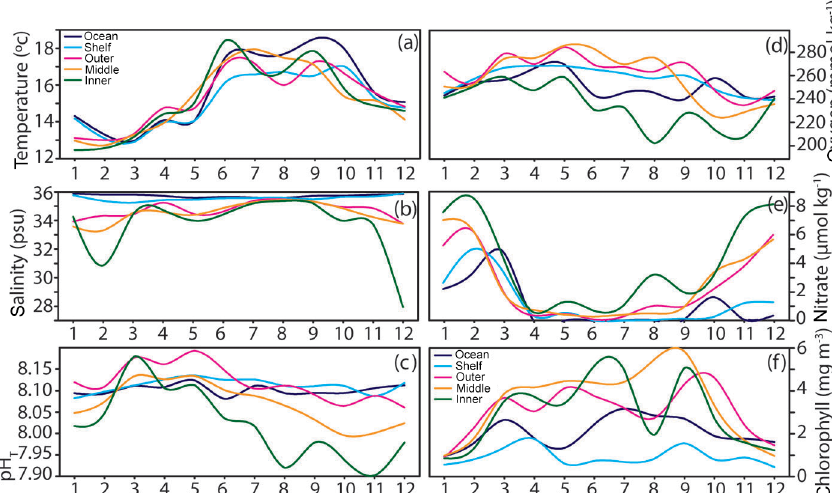
Figure 4. Sea surface ( < 5m depth) seasonal cycles in 1976–2018 of temperature (a) , salinity (b) , pH T (c) , oxygen concentration (d) , nitrate concentration (e) and chlorophyll (f) at sea surface for five geographical boxes shown in Fig. 1: South Ocean, RB shelf, and outer, middle and inner Ría de Vigo for the entire period of the ARIOS